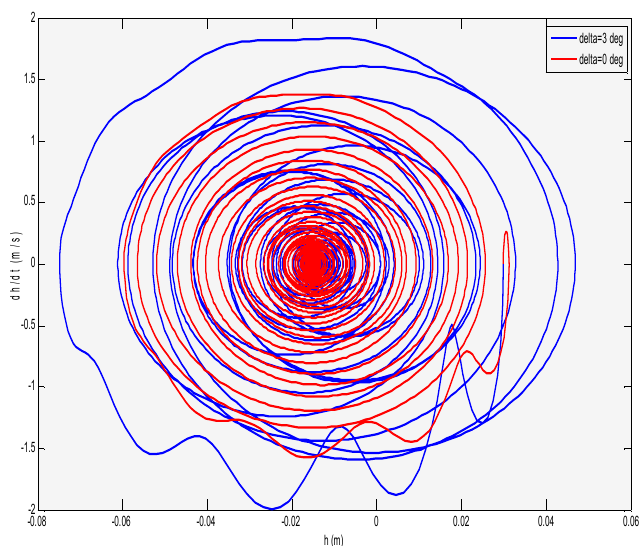
Figure 26. The state space response of “h” without freeplay and with 2 ◦ freeplay. (In lower speed of flutter).